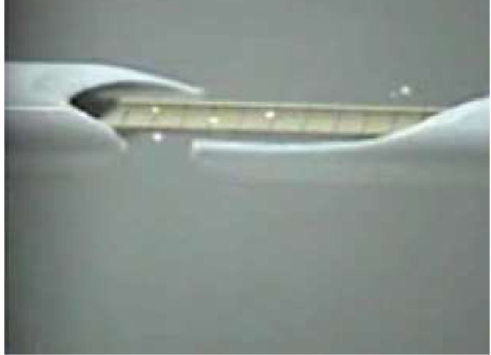
Figure 17. Corona ultraviolet image of fuse.